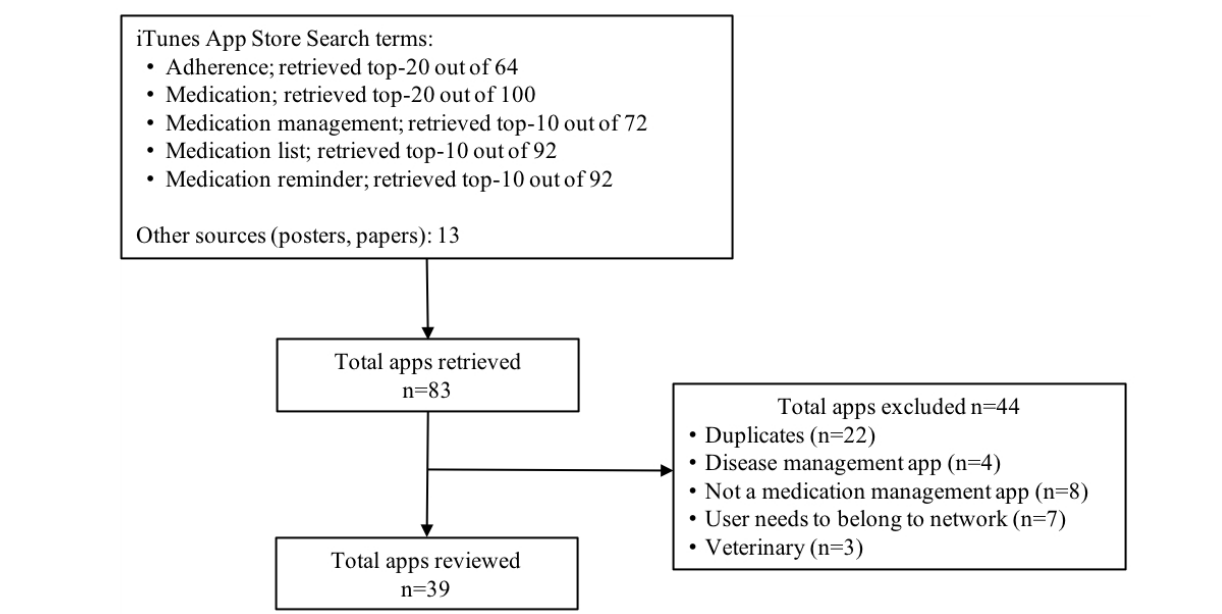
Figure 1. Flowchart of app search strategy and